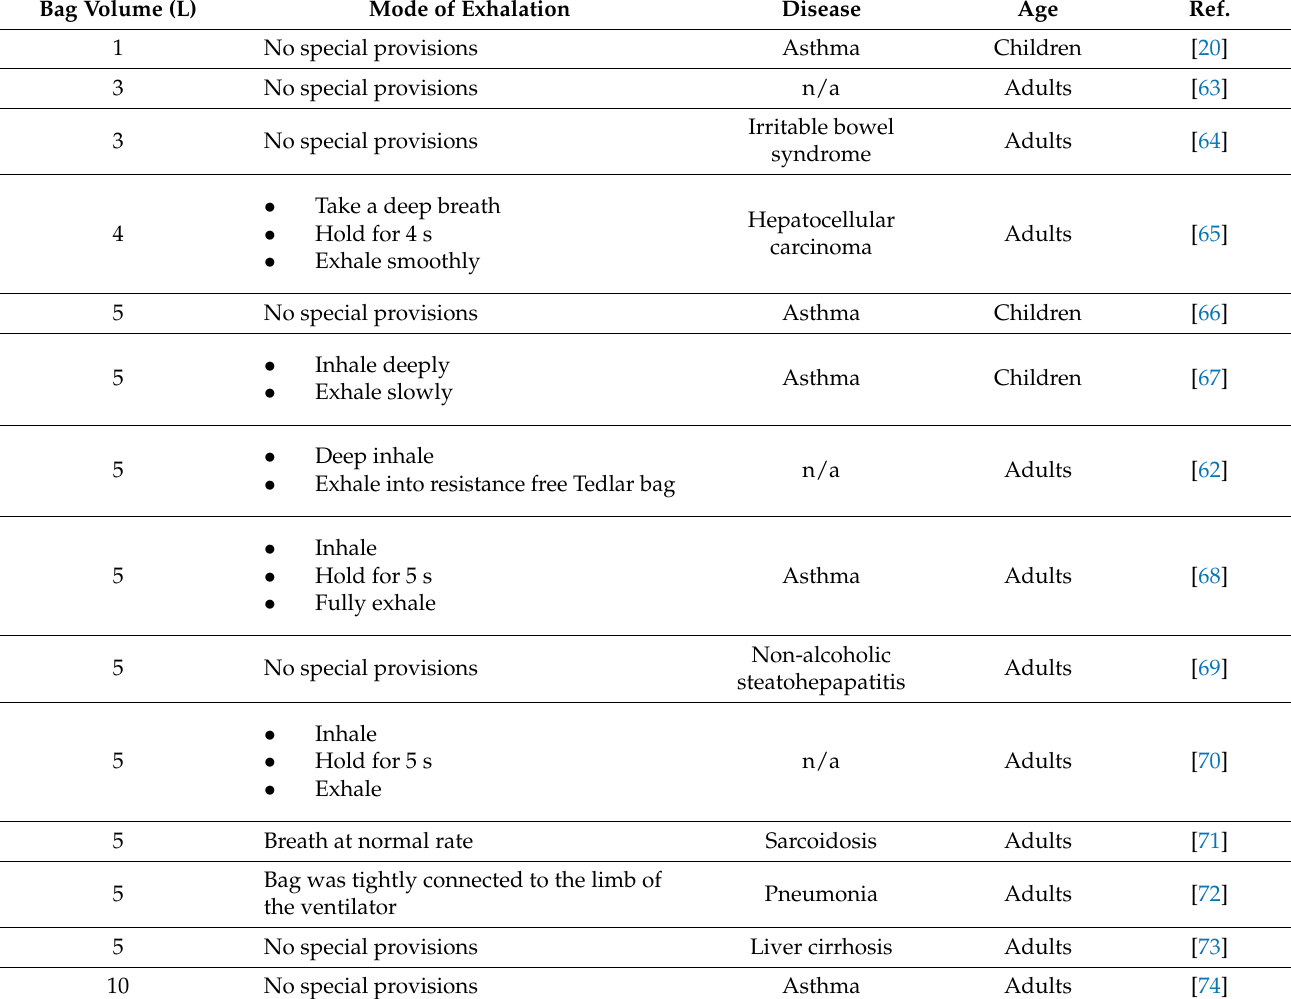
Table 2. Details regarding off-line breath